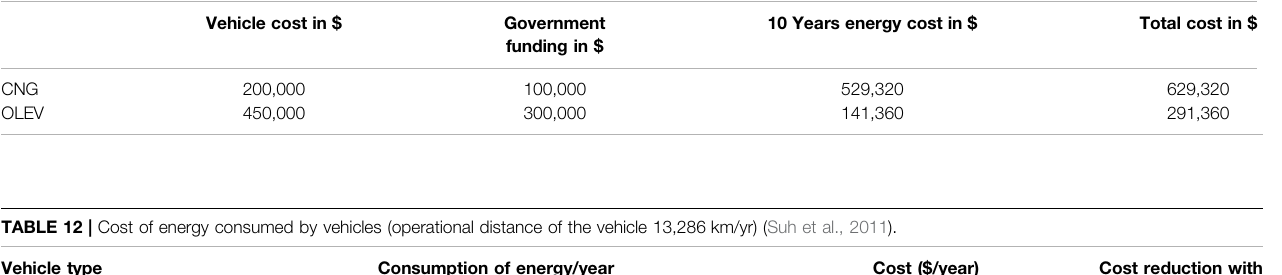
TABLE 11 | Analysis for 10 years (Suh and Dong, 2017).